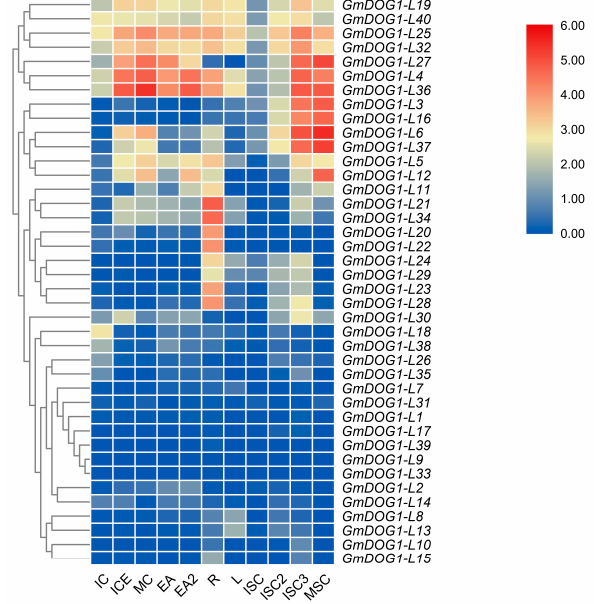
Figure 4. Hierarchical clustering of GmDOG1Ls transcriptome expression profiles including 11 samples at different tissue and developmental stages. Immature cotyledon (IC), immature cotyledon without embryo axis (ICE), mature cotyledon (MC), embryo axis-Stage: 300–400 mg (EA), embryo axis-Stage: 200–300 mg (EA2), roots (R), leaves (L), immature seed coat-Stage: 5–6 mg (ISC), immature seed coat-Stage: 25–50 mg (ISC2), immature seed coat-Stage: 200–300 mg (ISC3) and mature seed coat (MSC) were sampled for RNA-seq analysis.